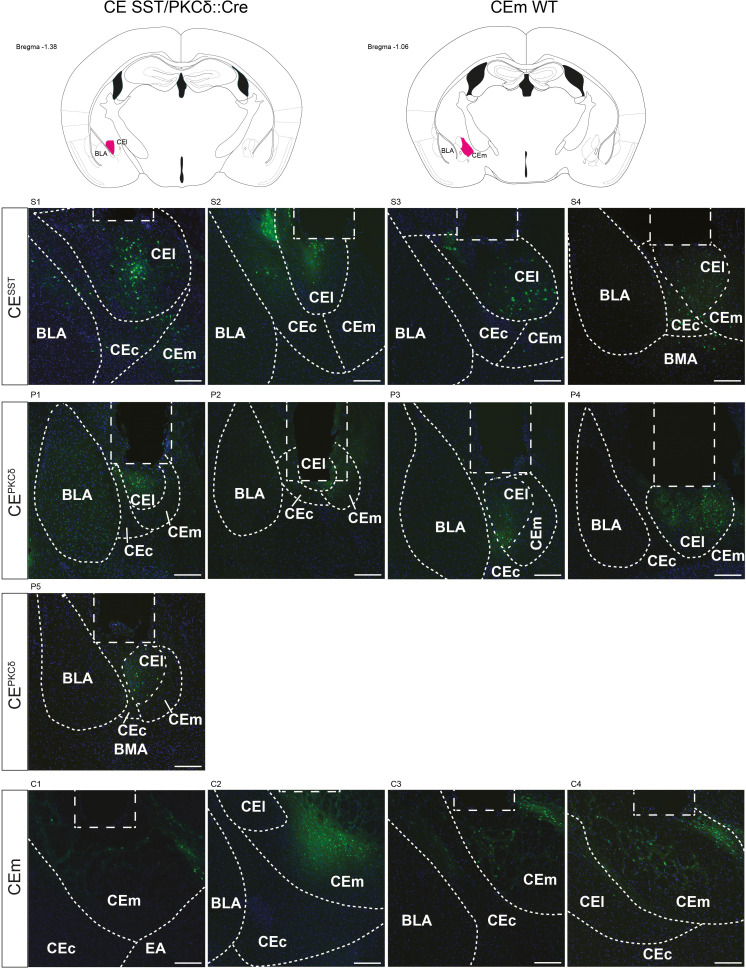
Histology of calcium imaging cohorts.Schematic coronal sections of targeted areas and from all calcium recording groups. SST::Cre and PKCδ::Cre mice were injected with AAV-hSyn-DIO-GCaMP6f in the right lateral central amygdala (CEl). WT mice were injected with AAV-hSyn-GCaMP6m in the right medial central amygdala (CEm). Rectangular dashed shape indicates GRIN lens placement (Ø=500 µm); scalebar = 200 µm. BLA – basolateral amygdala, BMA – basomedial amygdala, CEc, capsular part of central amygdala.